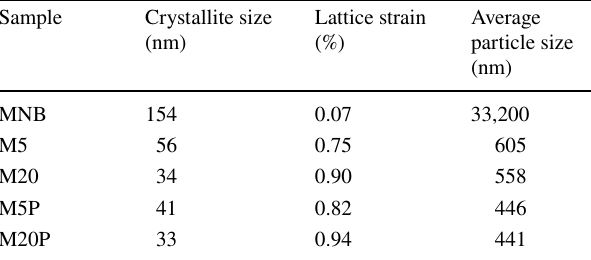
Table 3 Results of crystallite size, lattice strain, and average particle size measurements of different samples Sample Crystallite size